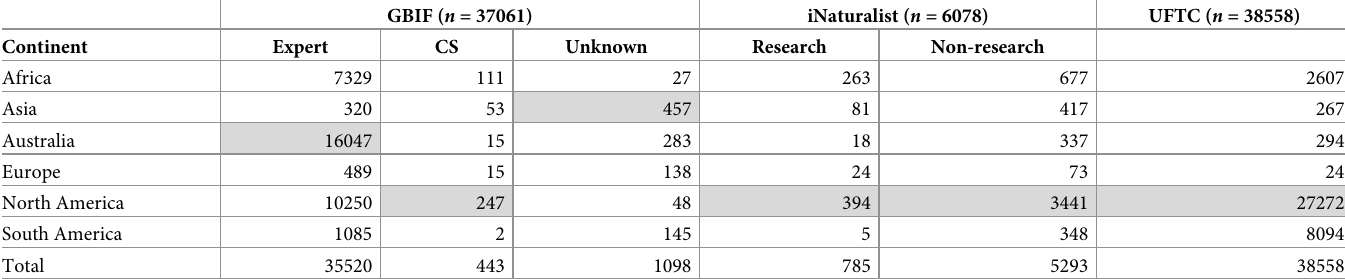
Table 1. Number of termite records in GBIF, iNaturalist, and the UFTC, separated by continent. Highlighted cells show the continent with the highest collection count per data